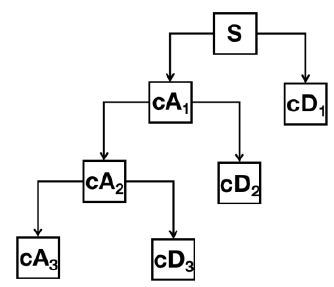
Figure 3. Schematic diagram of wavelet decomposition. Equations (1) and (2) are the process of decomposing the original signal into low- and high-frequency coefficients by passing it through different filtering functions. In Equation (3), the reconstruction of the signal is completed by sieving the high-frequency